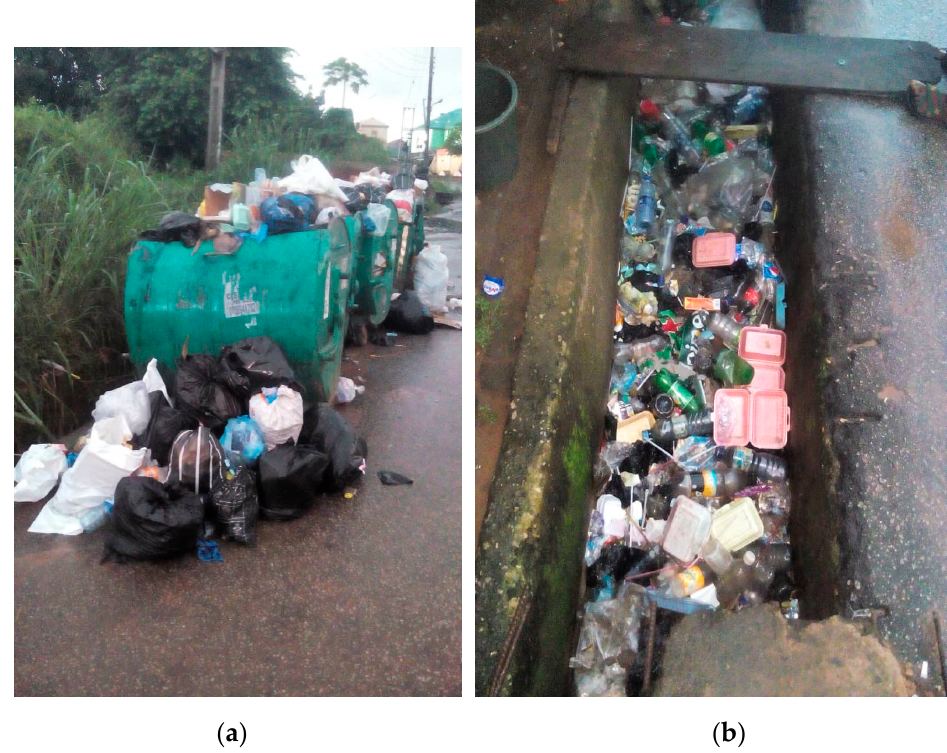
Figure 5. Municipal solid waste indiscriminately dumped ( a ) on the street in Nigeria ( b ) in the water channel.